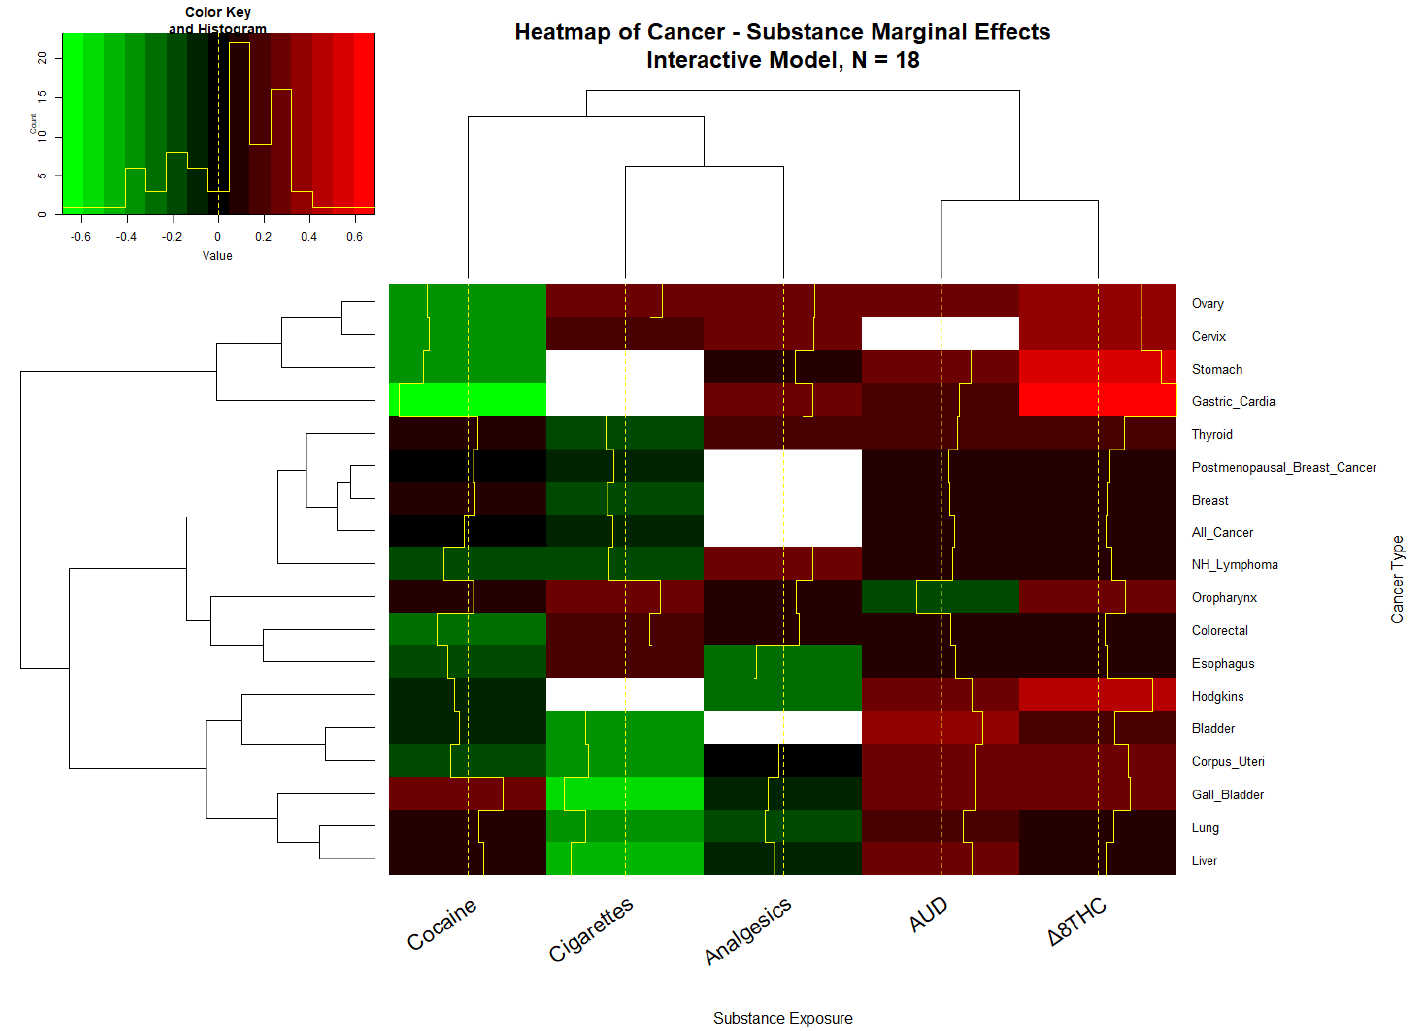
Figure 5. The heatmap of the cancer–substance marginal effects, Interactive IPW model.